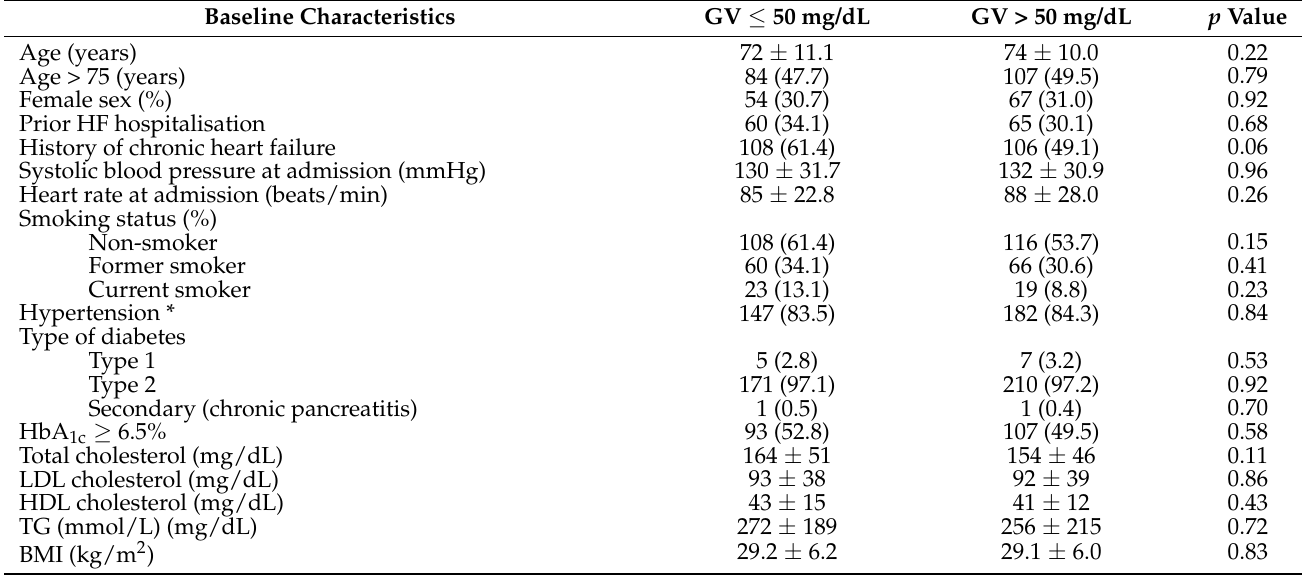
Table A1. Baseline characteristics of patients according to the GV status ((GV ≤ 50 mg/dL (or ≤ 2.70 mmol/L) and GV > 50 mg/dL (or >2.70 mmol/L)). Baseline